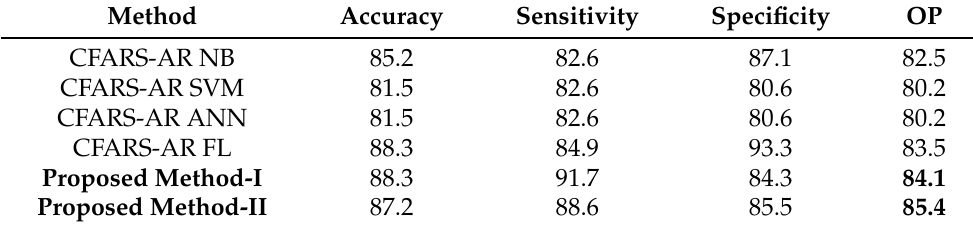
Table 3. Statlog Results.